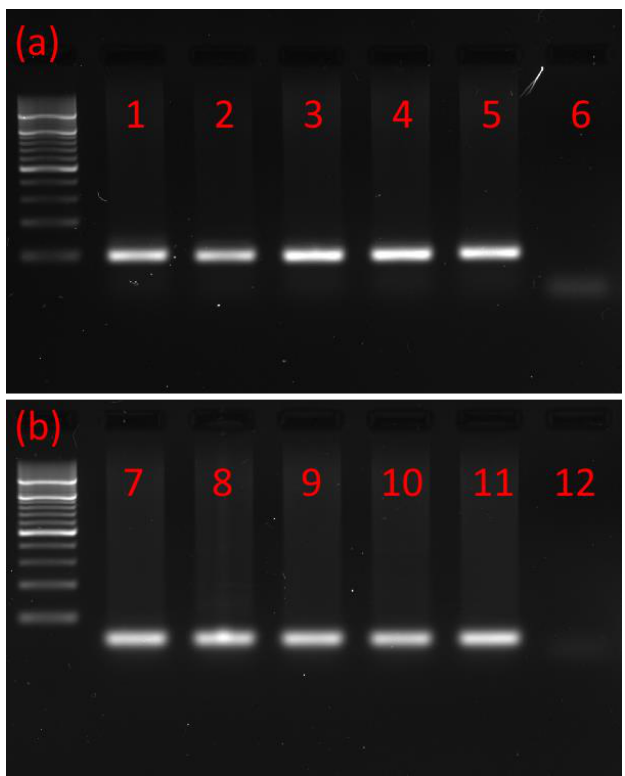
Figure 1. Typical agarose gel from gel electrophoresis of RT-PCR products. ( a ) PCR products with a mass of ≈200 bp showing that MIP/AST is present in the (1) adult brain, (2) adult CC/CA, (3) adult VNC, (4) pupal VNC, (5) larval VNC and (6) negative control. ( b ) PCR products with a mass of ≈100 bp showing that PISCF/AST is present in the (7) adult brain, (8) adult CC/CA, (9) adult VNC, (10) pupal VNC, (11) larval VNC and (12) negative control. CC/CA— corpus cardiacum/corpus allatum, VNC—ventral nerve cord. All lanes are from a single gel image, cropped for clarity and conciseness. The original gel is provided in “Supplementary Figure S1”.